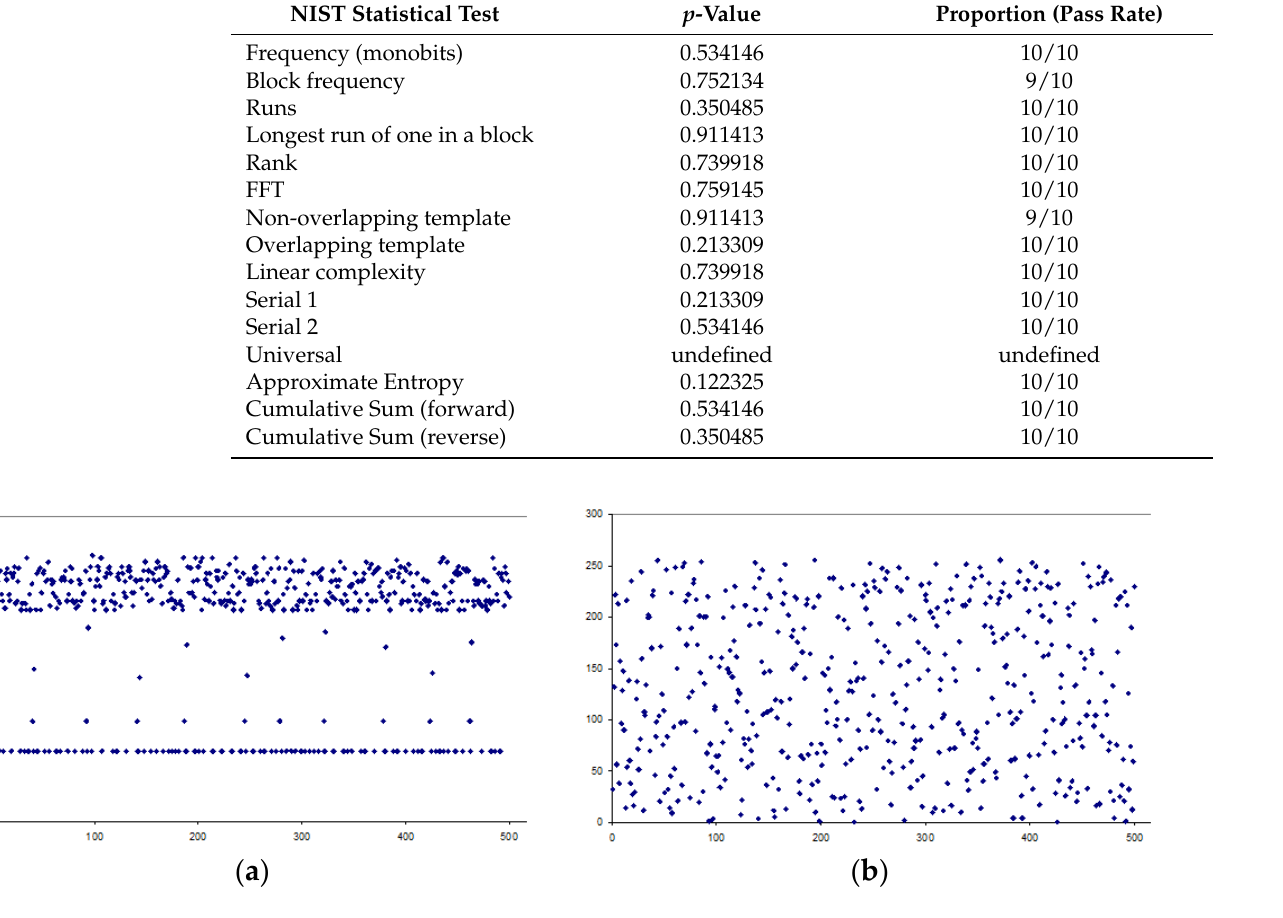
Figure 12. Dispersion of encrypted data over ASCII interval ( a ) Plaintext; ( b ) Ciphertext. The graph above depicts the distribution of original data (left side) and encrypted data (right side) across ASCII intervals. It is worth noting that the dispersion of the encrypted data is consistent across all intervals, implying that encrypted text is dispersed almost evenly throughout all ASCII intervals, not only